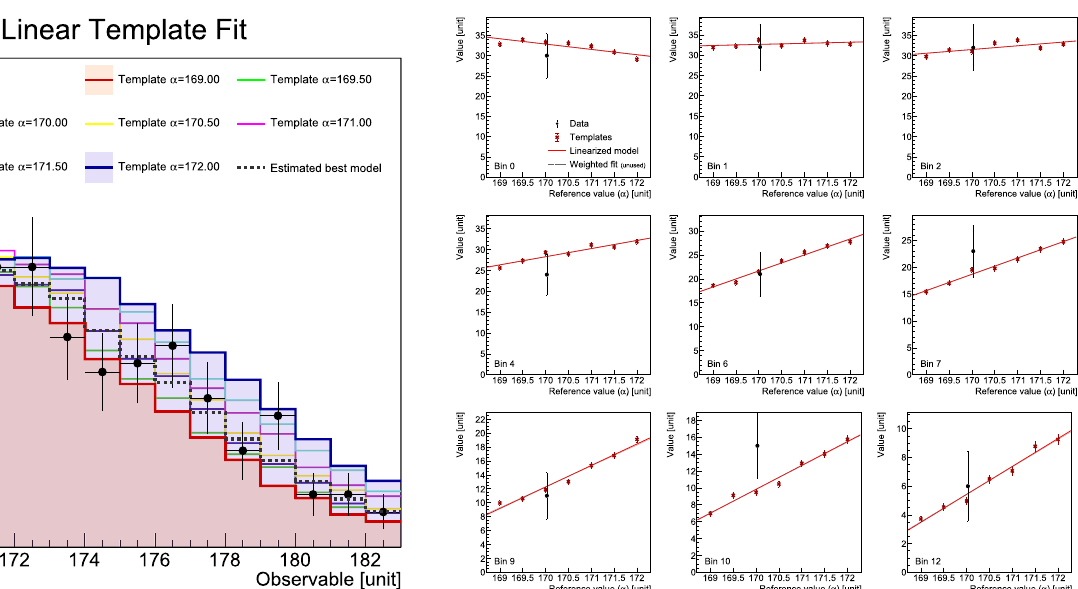
Fig. 1 Twoviewsofthetemplatematrix Y ofanexampleapplicationof the Linear Template Fit. Left: the template distributions Y as a function of the observable. The full circles display a pseudo-data set with sta- tistical uncertainties, and the dotted line indicates the estimated model after the fit, y ( ˆ α) . Right: the template distributions Y of an example application of the Linear Template Fit, but as a function of the refer-